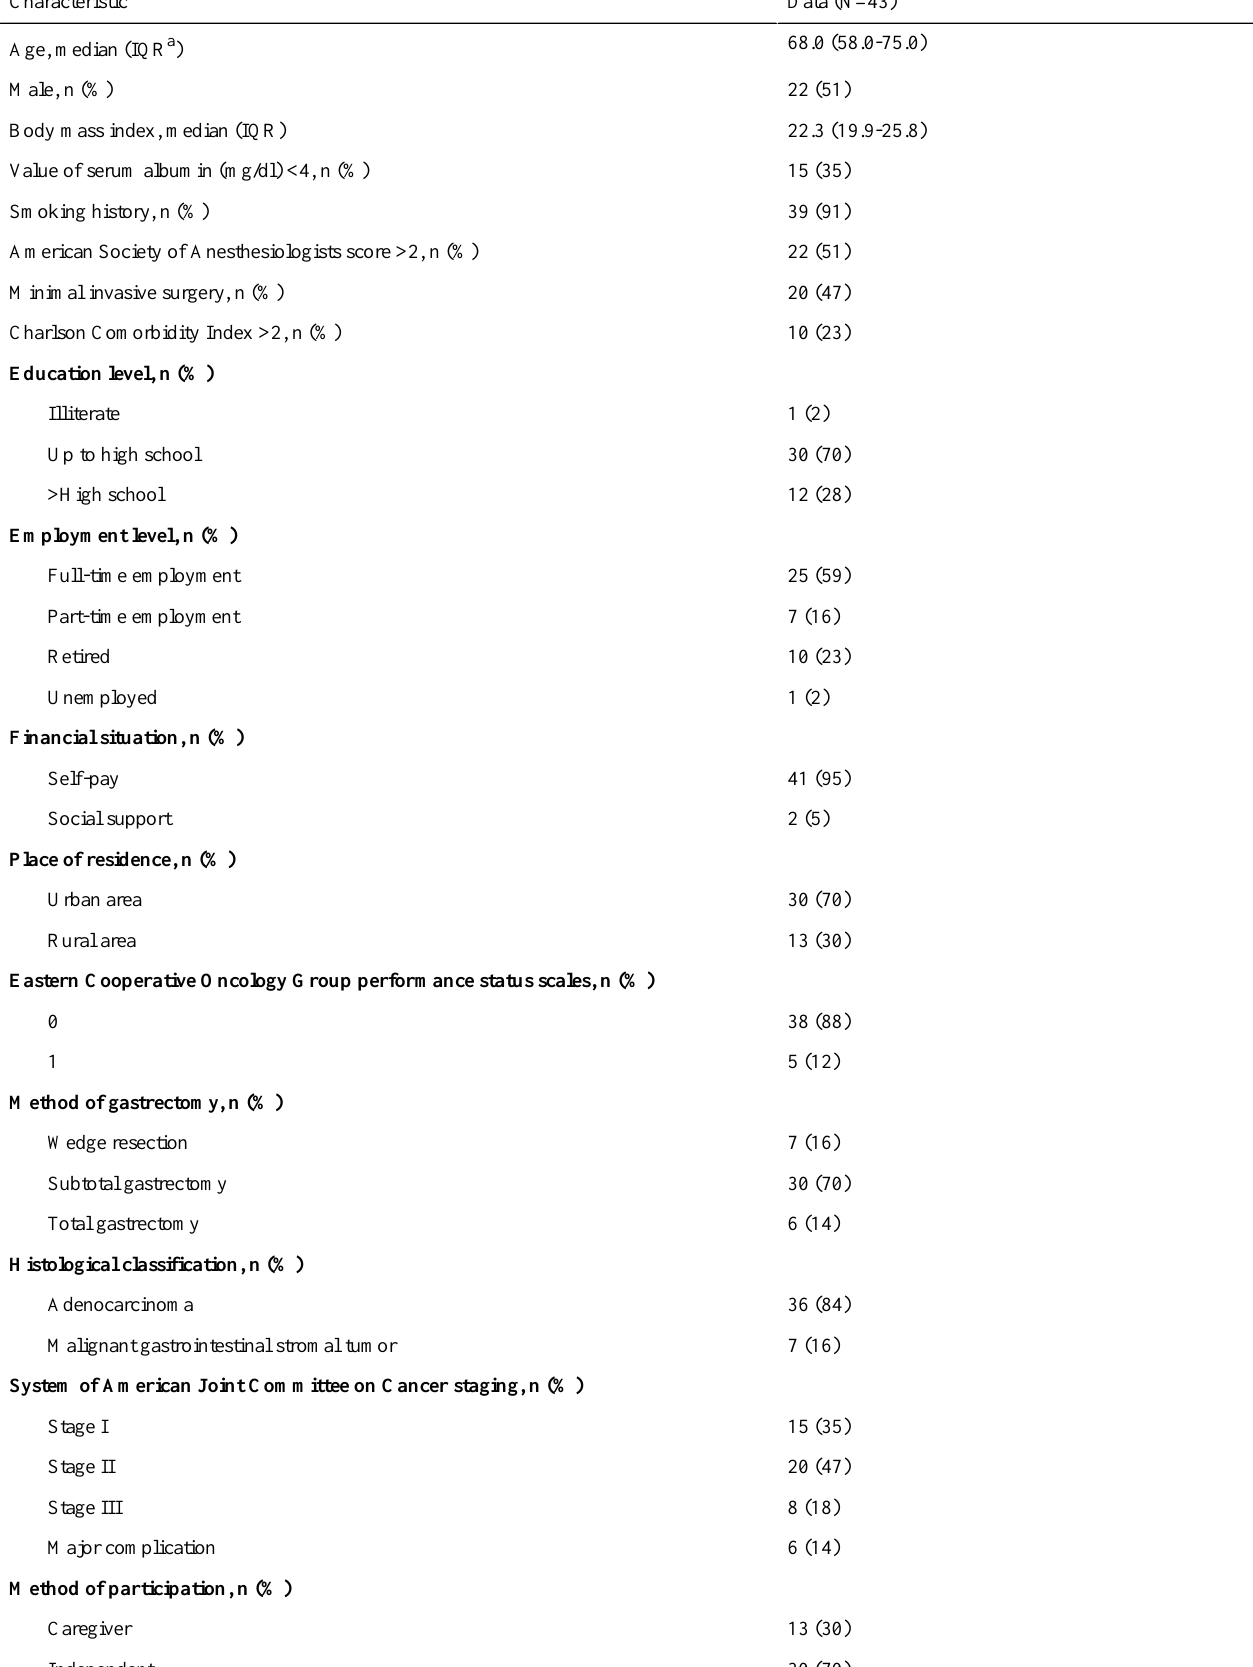
Table 1. Demographic characteristics of study subjects, participant adherence to the protocol, and clinical